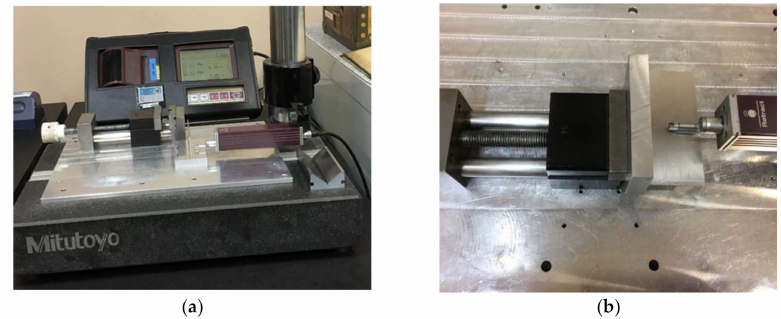
Figure 6. Measurement of the surface roughness (Ra) using Mitutoyo SJ-301 device: ( a ) Horizontal surfaces; ( b ) Vertical